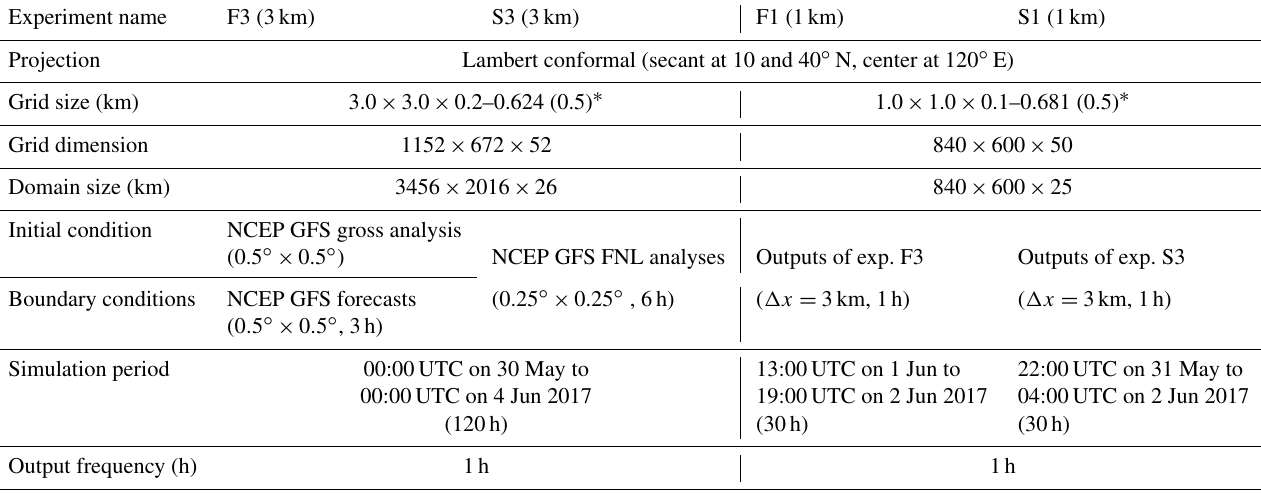
Table 2. The domain configuration, initial and boundary conditions, simulation period (UTC), and other relevant settings of four CReSS experiments (F3, F1, S3, and F1) to investigate the heavy rainfall mechanism in this study. For grid configuration, the numbers are in x × y × z . The F3 experiment is the same as M18 in WLC21.